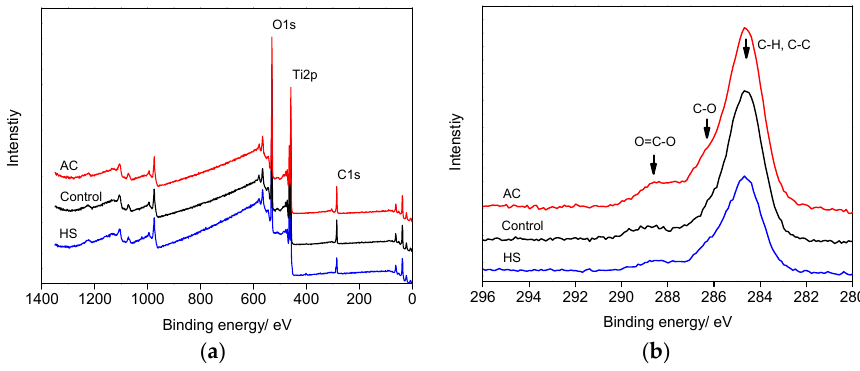
Figure 2. X-ray photoelectron spectroscopy survey scans ( a ) and C1s scans ( b ) of different specimens.